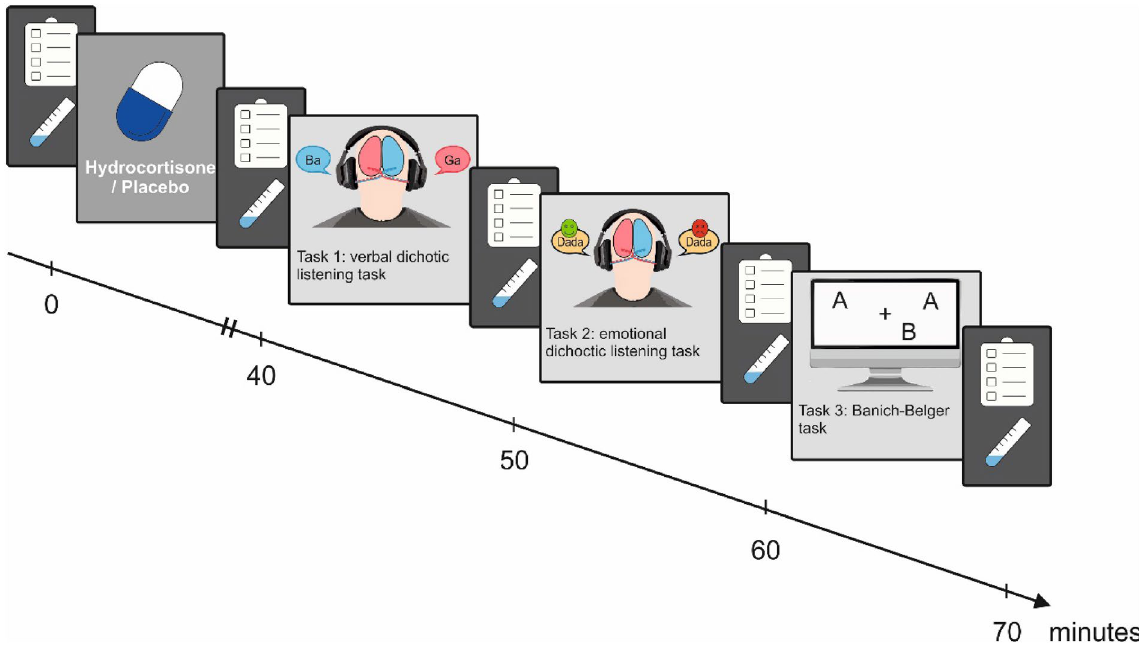
Figure 1. Experimental design. After administration of hydrocortisone or placebo, the participant is tested using verbal dichotic listening, emotional dichotic listening and the Banich–Belger task. Before hydrocortisone administration and after each section of the experiment, cortisol and affect are